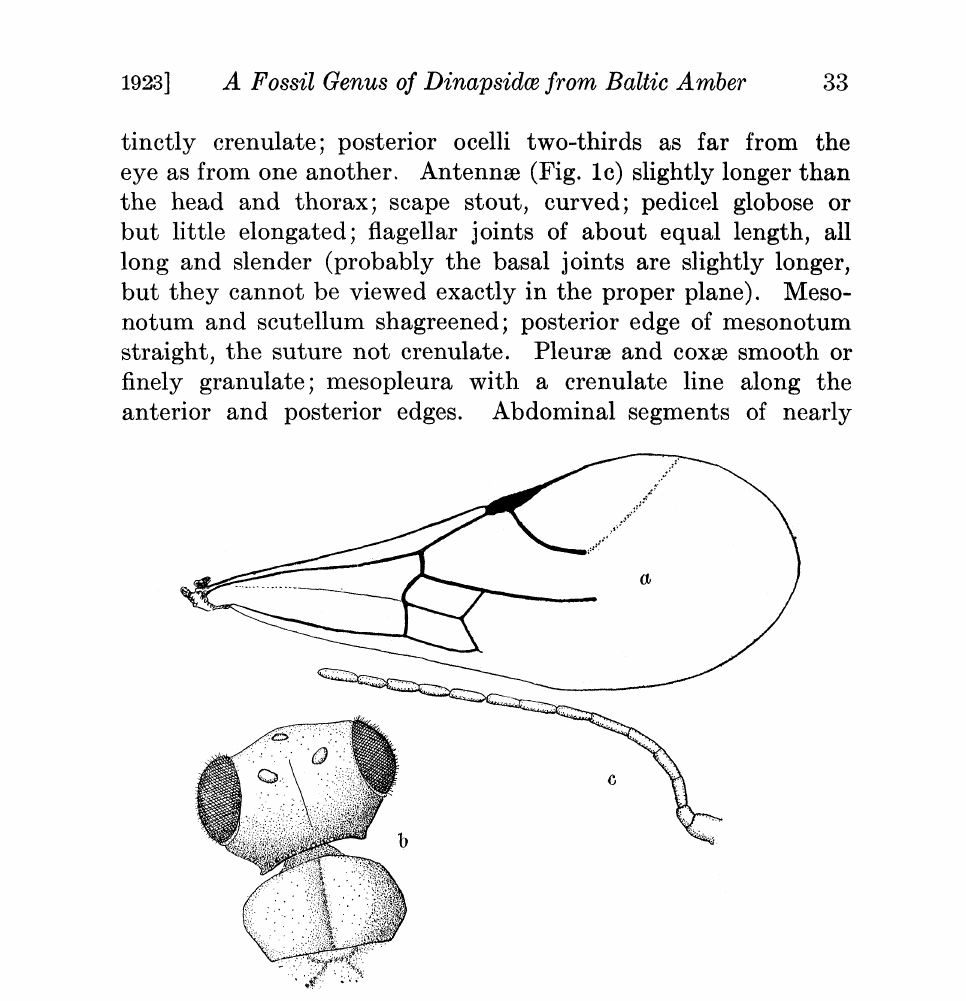
Fig. 1. Prodinapsis succinalis sp. nov. A, wing; B, head and anterior portion of thorax, C, antennae equal length, the second and also the first slightly, but not very noticeably, longer than the others; the posterior edges of the segments sinuous and slightly incised medially. Claspers almost as long as the dorsal length of the sixth segment. Wings ample,. the margins with the usual short fringe of hairs, but none of the veins appear to be bristly as in